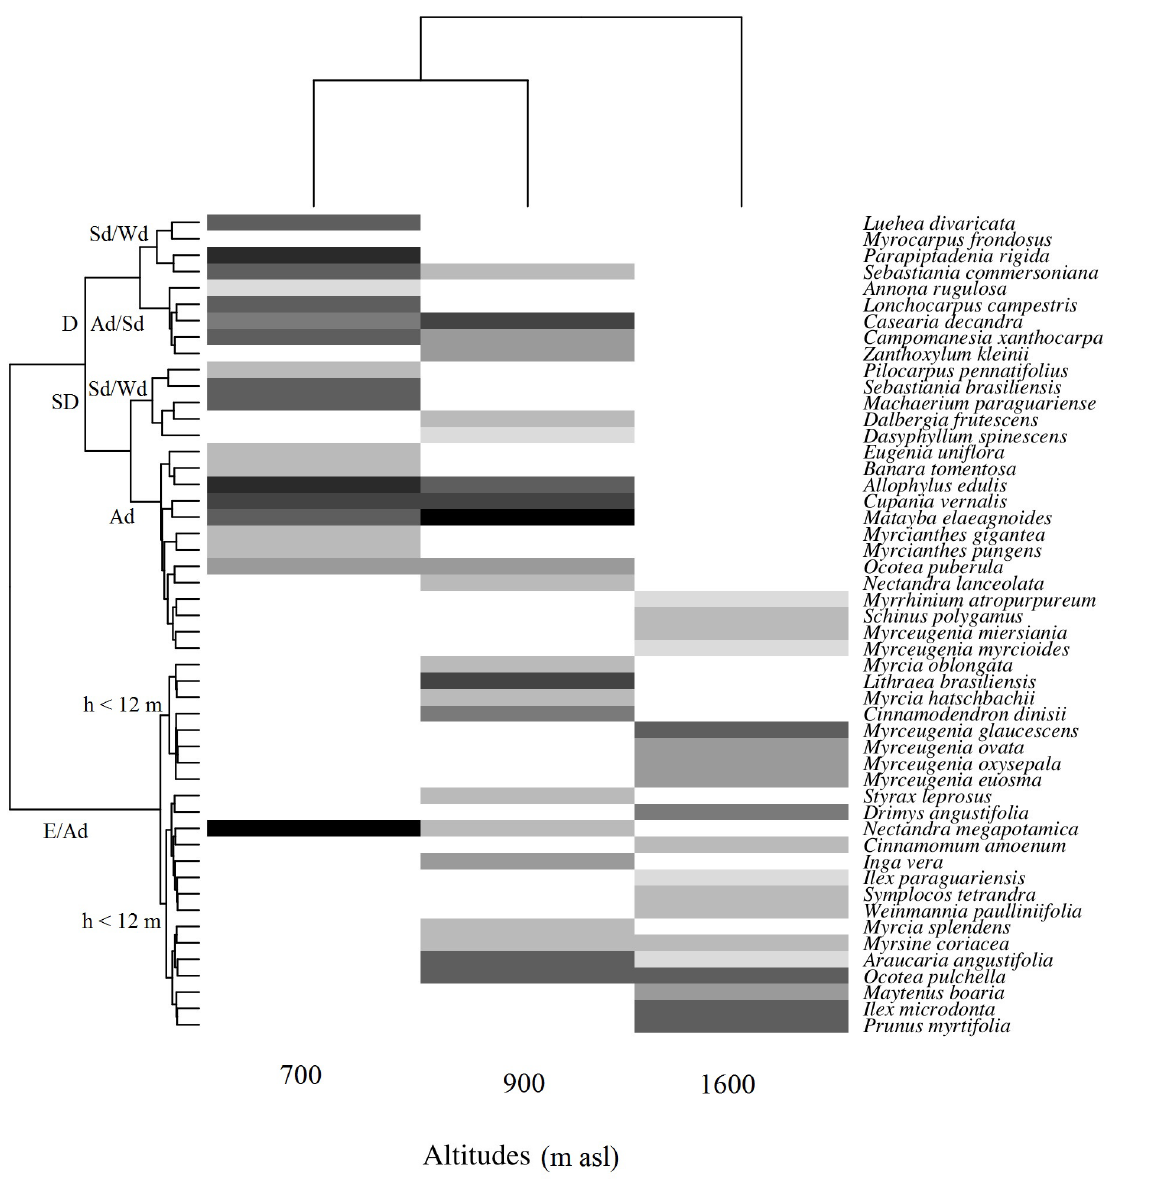
Figure 1 - Heatmap showing the distribution of tree species in araucaria forest areas, across an altitudinal gradient, in the southern plateau of Santa Catarina, Brazil. Darker shades indicate a greater abundance of species. The dendrogram at the top indicates the floristic-structural similarity among areas and the dendrogram on the side indicates the functional similarity among species (SD = semi-deciduous; D = deciduous; E = evergreen; Sd = self-dispersed; Wd = wind-dispersed; Ad = Animal-dispersed, h = tree